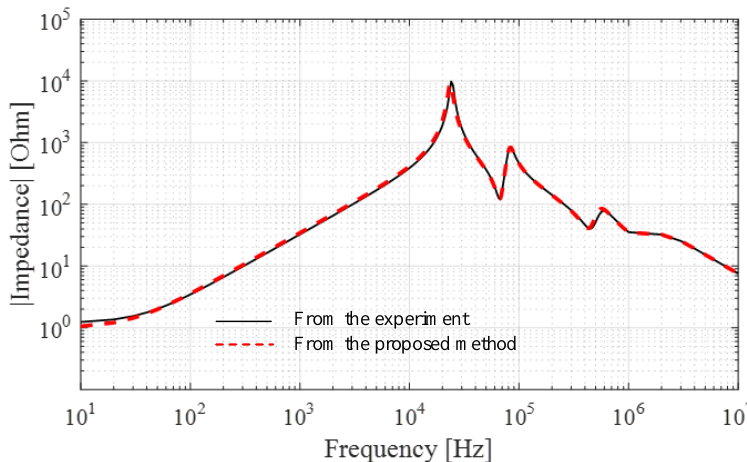
Figure 16. Magnitude of input impedances of the transformer winding from the measurement and the proposed method.